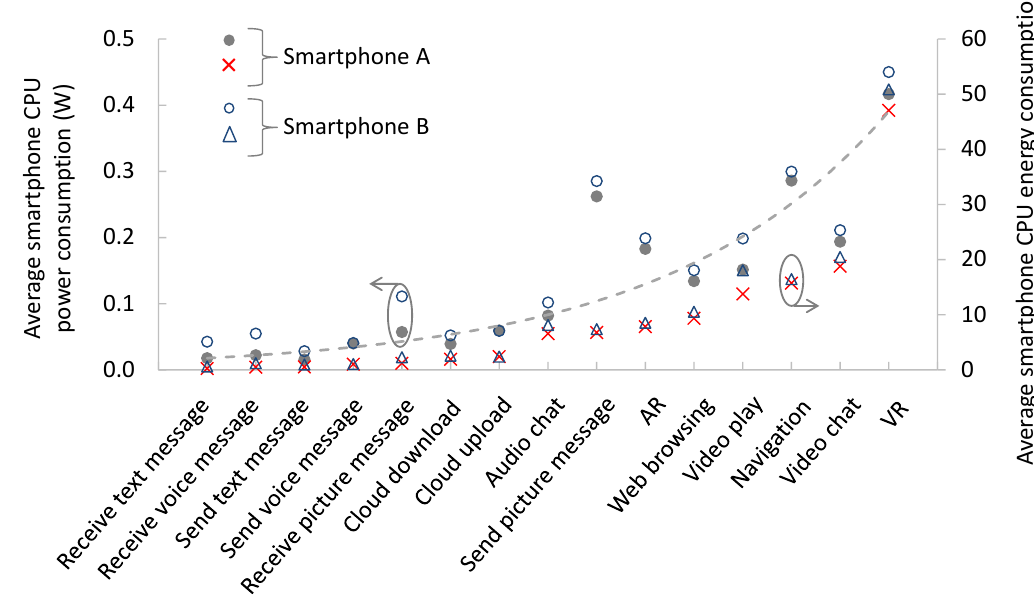
Figure 4. Smartphone’s CPU power and energy consumption for 15 different types of mobile services. Note that the services are sorted by CPU energy consumption and average measurements for two types of smartphones are plotted to demonstrate the consistency of the measurements.